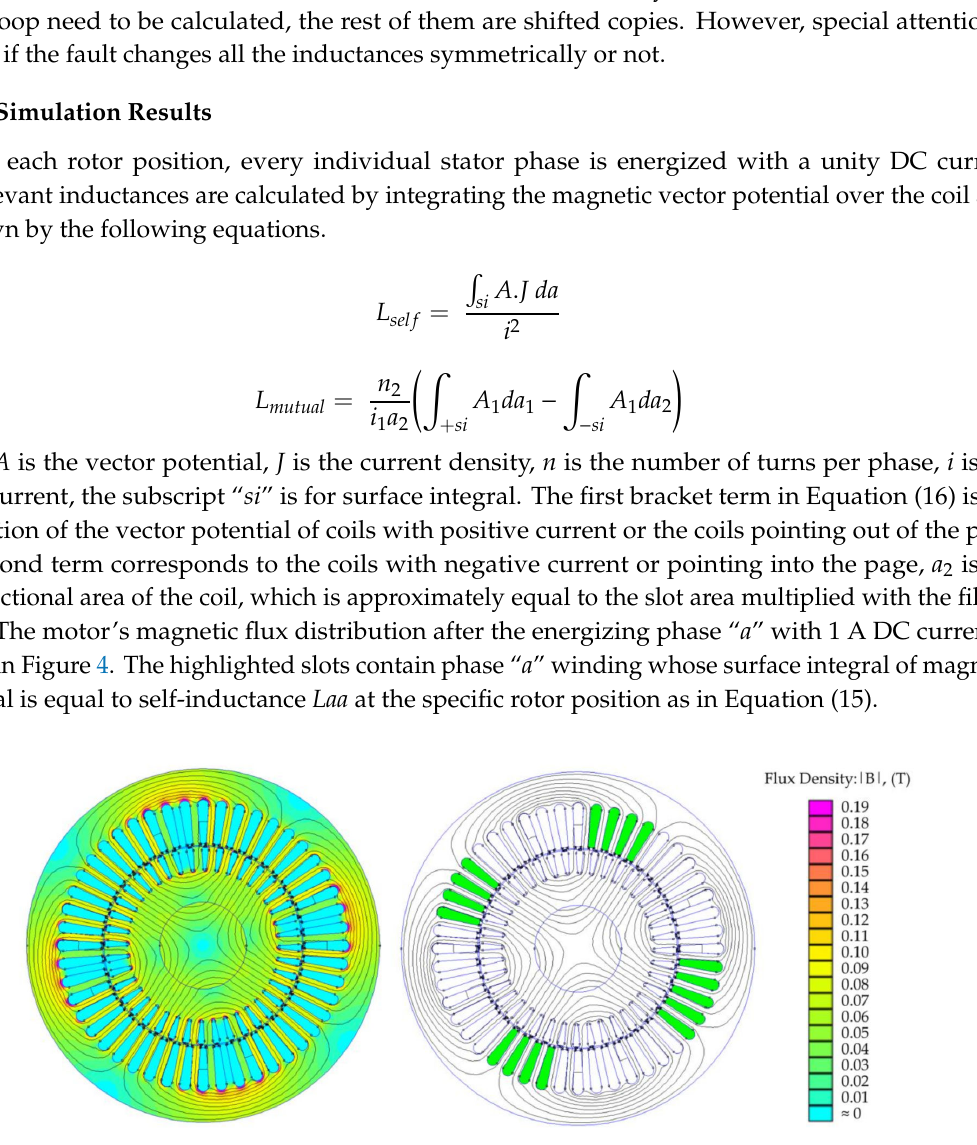
Figure 4. The flux distribution with energized phase “ a ” with I DC = 1 A, and the selection of slots for vector potential integral for calculation of self-inductance L aa